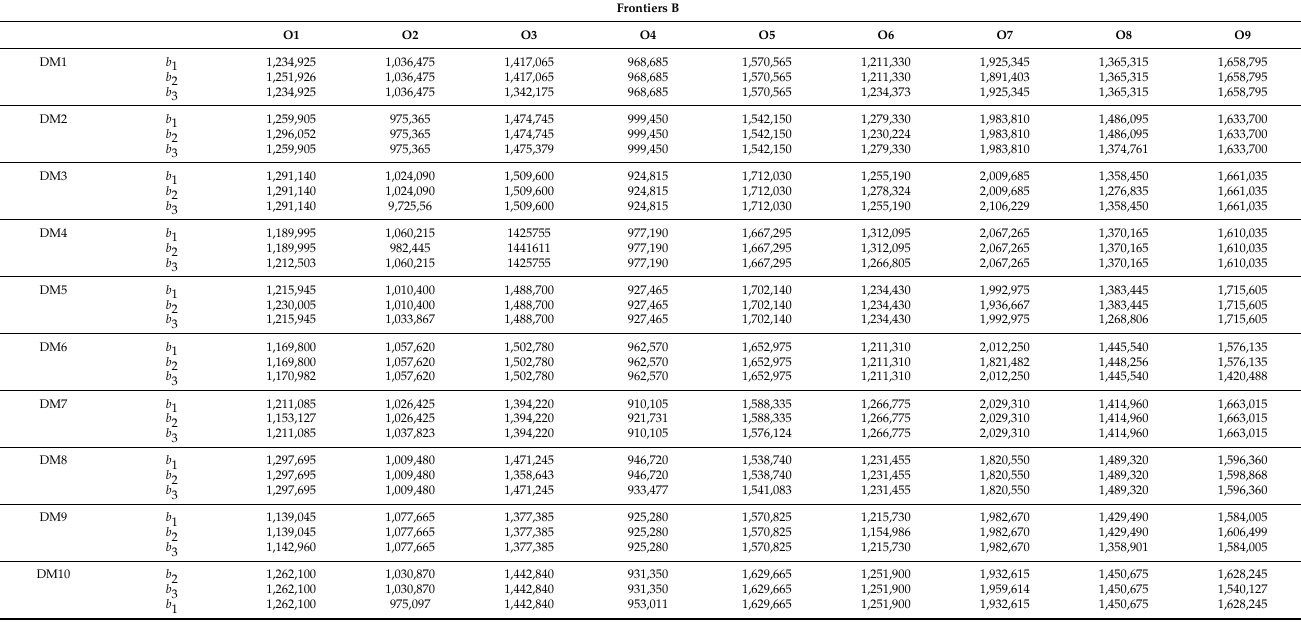
Table A3. Limiting boundaries.